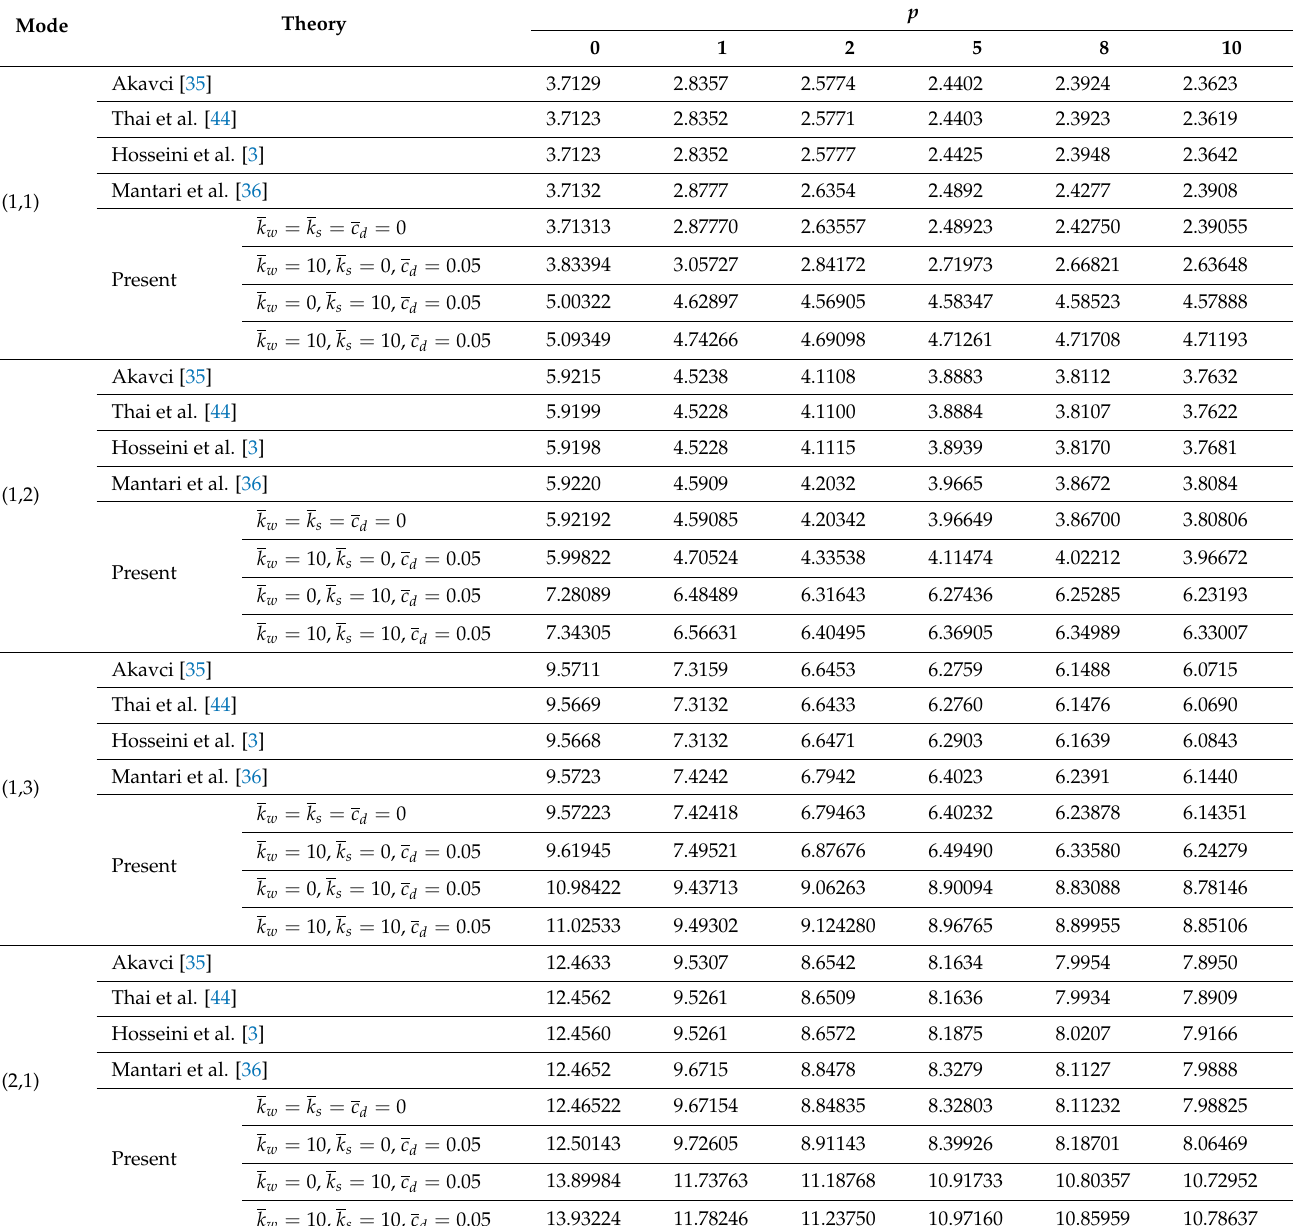
Table 10. Non-dimensional natural frequencies ˘ ω = plates resting on Visco-Winkler-Pasternak foundations ( b / a = 2, a / h =